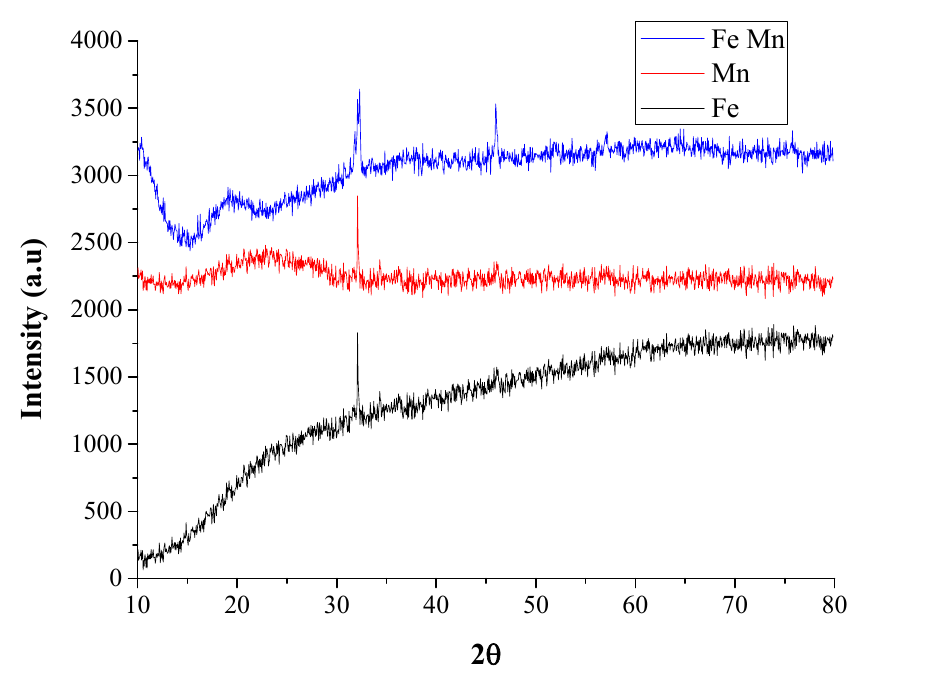
Figure 3. XRD spectra Fe, Mn and Fe-Mn NPs. Table 1. XRD Diffraction Pattern of Fe NPs.